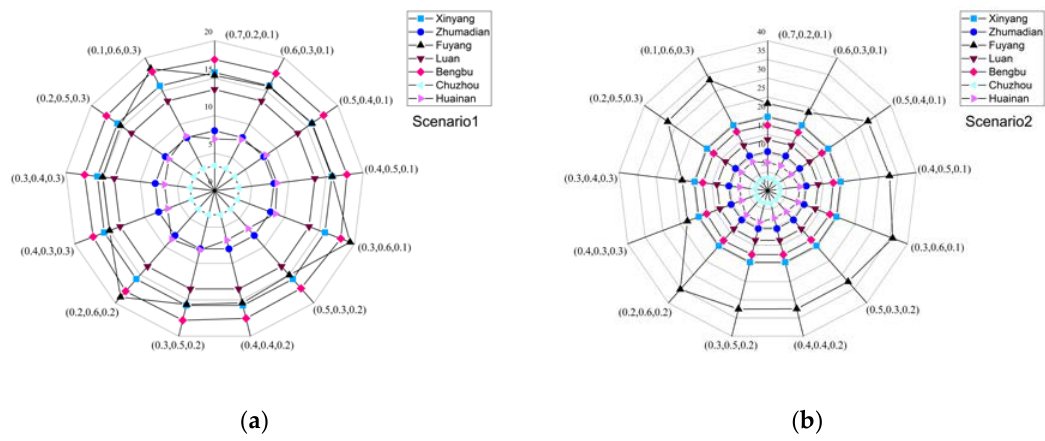
( b ) 2050, (0.7 0.2 0.1) means ω 1 = 0.7, ω 2 = 0.2, ω 3 = Figure 6. Total economic benefits of different subareas with different sets of objective weights (( a ) 2020,